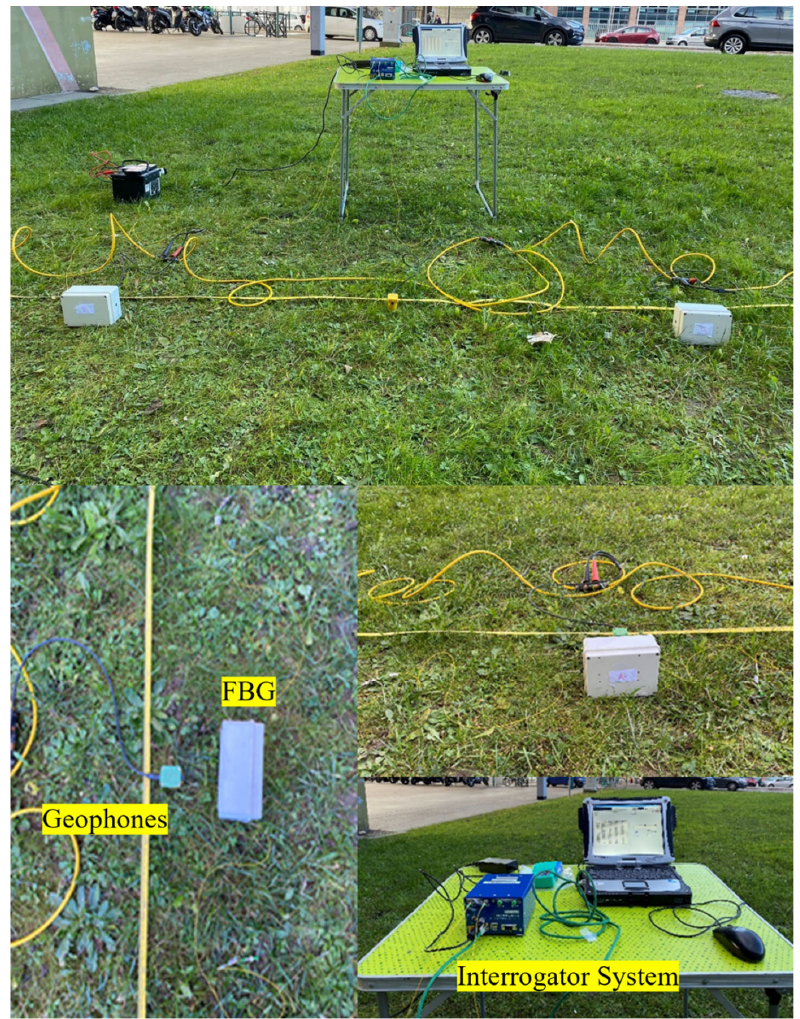
Figure 11. Field test of the calibrated system with the parallel standard geophones.